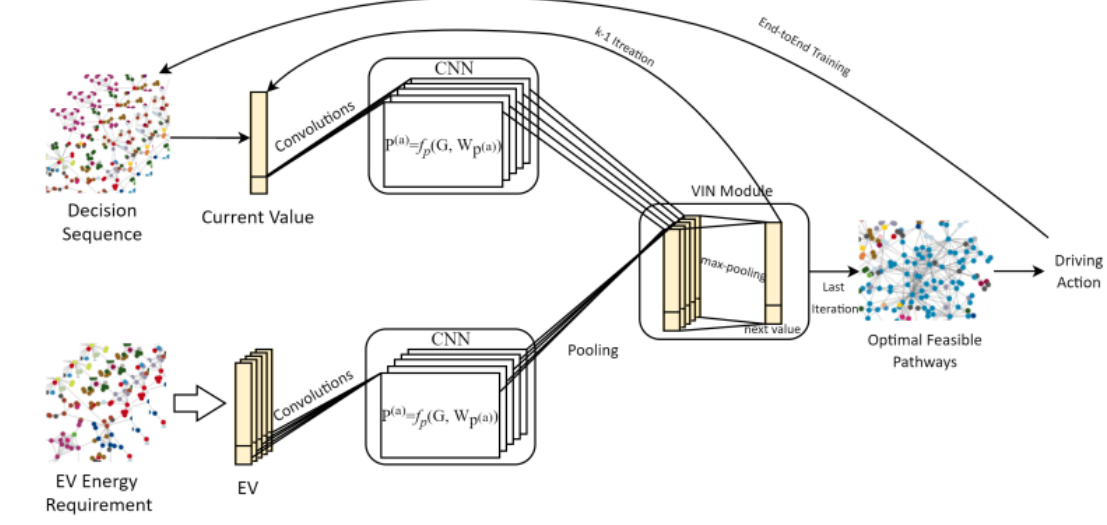
Figure 5. Illustration of the value function feedback iterations in the learning process.